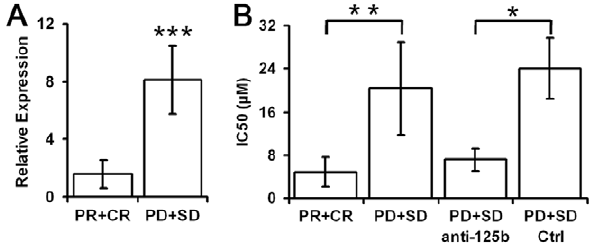
Figure 3. MiR-125b expression correlated with chemothera- peutic resistance in primary breast cancer cells. (A) MiR-125b expression was determined by quantitative RT-PCR. (B) Primary breast cancer cells were treated with 5-FU for 48 h with or without miRNA antisense transfection (100 nM). IC50 was calculated as concentration of 5-FU to produce 50% cell inhibition (Materials and Methods). Data represented mean 6 SD of primary breast cancer cell cultures from 5 patients with partial or complete response (PR + CR) and from 4 patients with disease progression or stabilization (PD + SD), * p =0.01, ** p =0.002, *** p , 0.001.